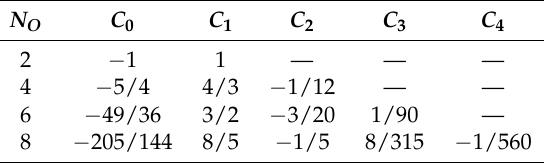
Table 1. Numerical scheme